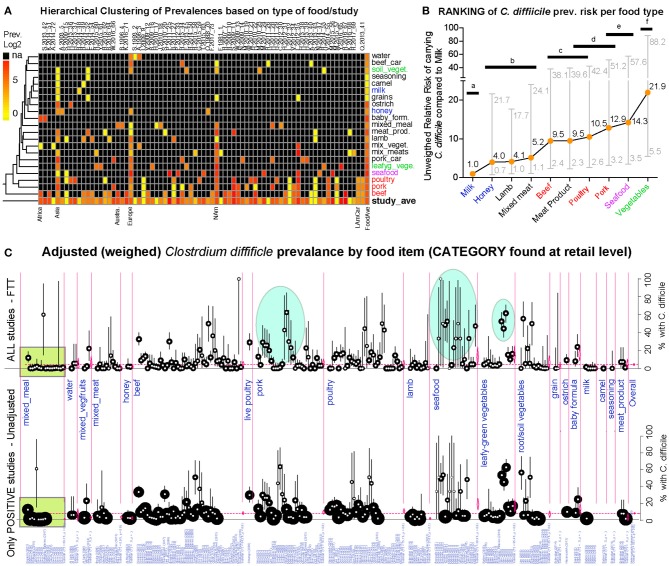
Global risk ranking of foods based on probability of carrying C. difficile illustrates higher heterogeneity for pork, poultry, seafood, and vegetables. A version in PDF that can be magnified to limiteless resolution is available in FigShare. (A) Hierarchical unsupervised analysis of reported prevalence of C. difficile (CD) in various food items (y-axis labels) across regions and studies (x-axis). Note that several studies processed various types of foods. na, not tested. (B) Ranking of foods based on the expected risk of carrying CD (Relative Risk Ratios [RRR] and 95% CI). Note that the RRR ranks beef, poultry, pork, and vegetables at different levels although they cluster together in panel a, which clusters these products together because those were more commonly tested across regions. Horizontal bars connect products with statistically similar RRR. Distinct superscripts denote statistical differences, Chi-square p < 0.05. (C) Meta-analytic display of weighed prevalence estimates at the “food set” level. Top panel displays data from all studies, including “zero” prevalence reports (Arcsine transformation, homogeneous adjustment for variability, see comparably-sized small circles), while the top panel displays data of only positive studies (larger variably-sized circles, see area within rectangular polygon). Vertical ovals in top panel highlight representative clusters of reports describing high prevalence of C. difficile in certain foods, supports raking statistics in (B). Leafy green vegetables are ranked high since estimates are from studies with larger sample sizes/more weighed influence (small circles, narrower CI in bottom panel; larger circles in arcsine-adjusted top panel).